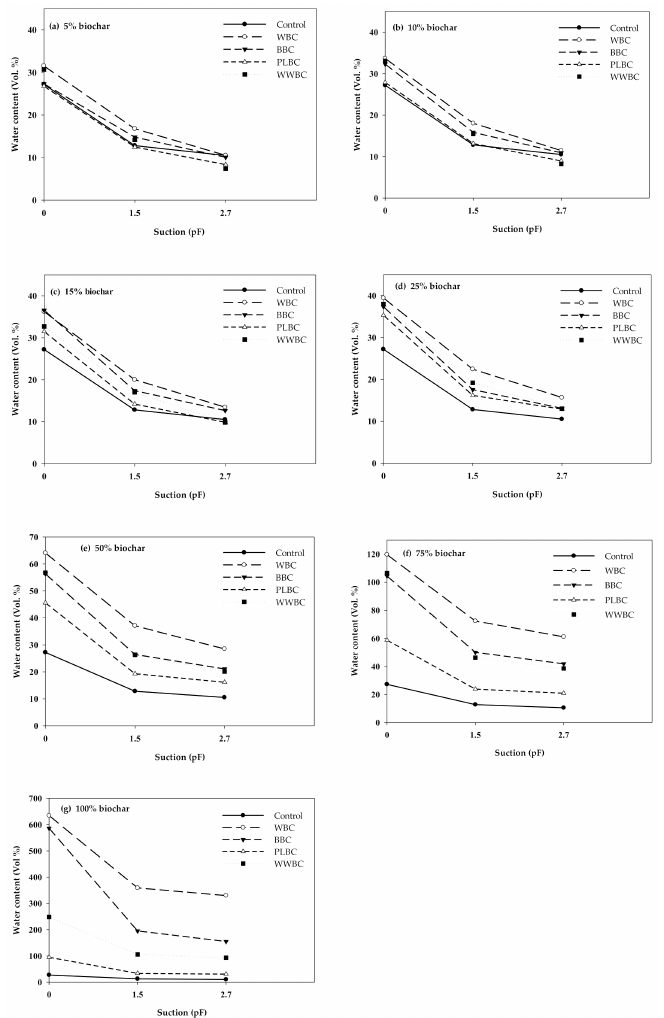
Figure 2. Soil water retention curves for sandy soil amended with woodchip biochar (WBC), bagasse biochar (BBC), poultry litter biochar (PLBC) and waterweed biochar (WWBC) at ( a ) 5%, ( b ) 10%, ( c ) 15%, ( d ) 25%, ( e ) 50%, ( f ) 75% and ( g ) 100% biochar rates ( v / v